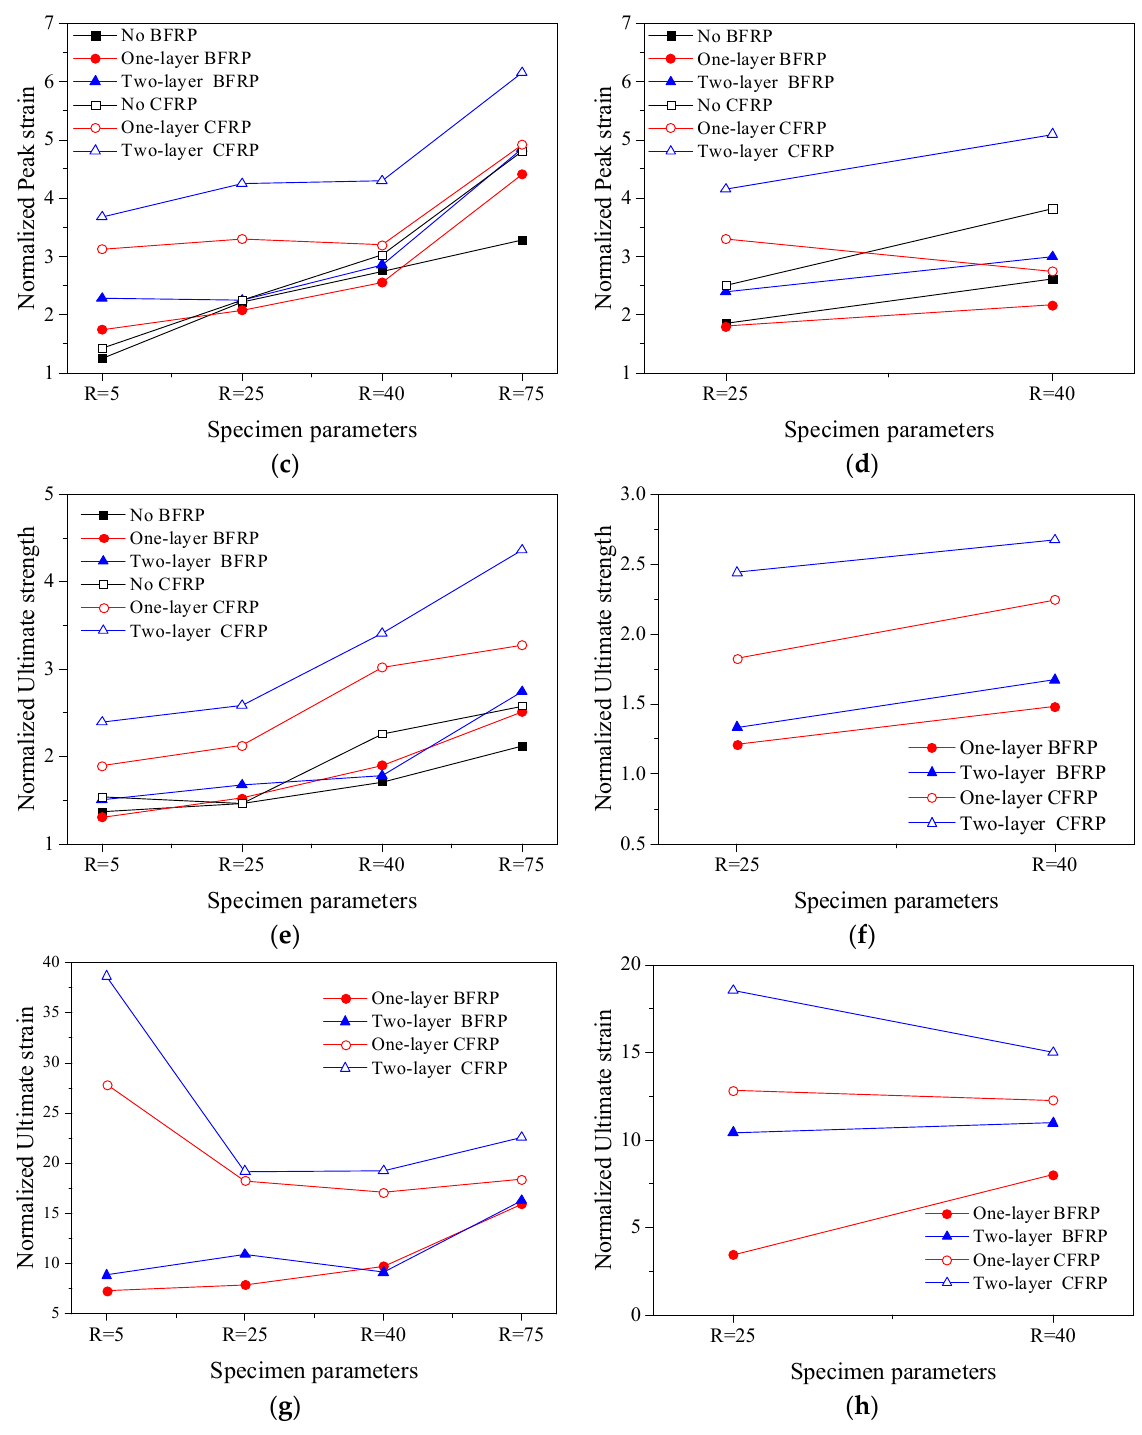
Figure 8. Comparison of the performance of FRP–stirrup-confined rectangular concrete columns: ( a ) peak stress (S20); ( b ) peak stress (S40); ( c ) peak strain (S20); ( d ) peak strain (S40); ( e ) ultimate stress (S20); ( f ) ultimate stress (S40); ( g ) ultimate strain (S20); ( h ) ultimate strain (S40). When the FRP layers, stirrup spacing and FRP type are the same, the larger the corner radius of the cross-section, the better the improvement of the mechanical properties of FRP–stirrup composite-confined concrete specimens. When the stirrup spacings were 20 mm, compared with the ultimate stress and the ultimate strain of plain concrete columns, with the increases of corner radius of outer FRP (R = 5, 25, 40, 75 mm), the peak stress, peak strain, ultimate stress and ultimate strain of specimens confined by two layers of CFRP increased by 1.57 to 2.41 times, 6.13 to 7.68 times, 2.42 to 4.34 times and 19.15 to 22.65 times, respectively; the peak stress, peak strain, ultimate stress and ultimate strain